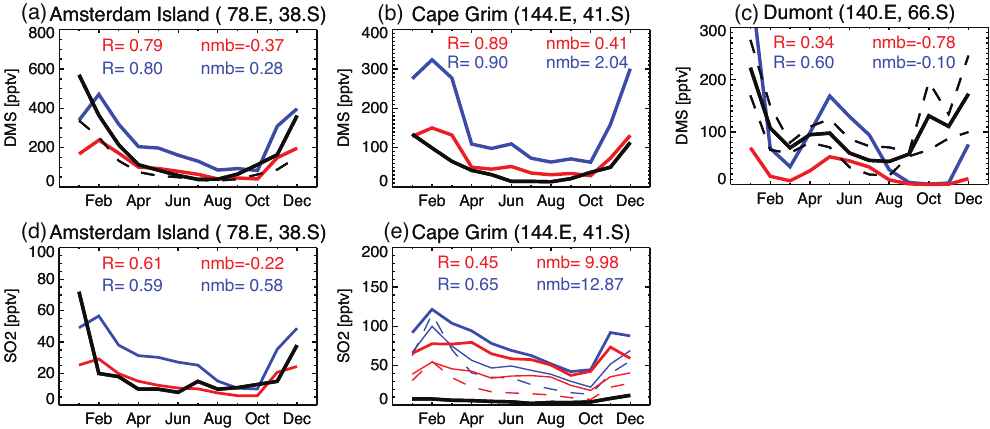
Figure 3. Comparisons of monthly averaged surface DMS ( a to c ) and SO 2 ( d to e ) mixing ratios (pptv) simulated (red for ModelE2-TOMAS and blue for ModelE2-OMA) and measured (black) at Amsterdam Island (Nguyen et al., 1992) and Cape Grim (Ayers et al., 1991). Only DMS at Dumont D’Urville (Jourdain and Legrand, 2001). Correlation ( R ) and normalized mean bias (NMB) are given. Christmas Island(AUG-OCT)